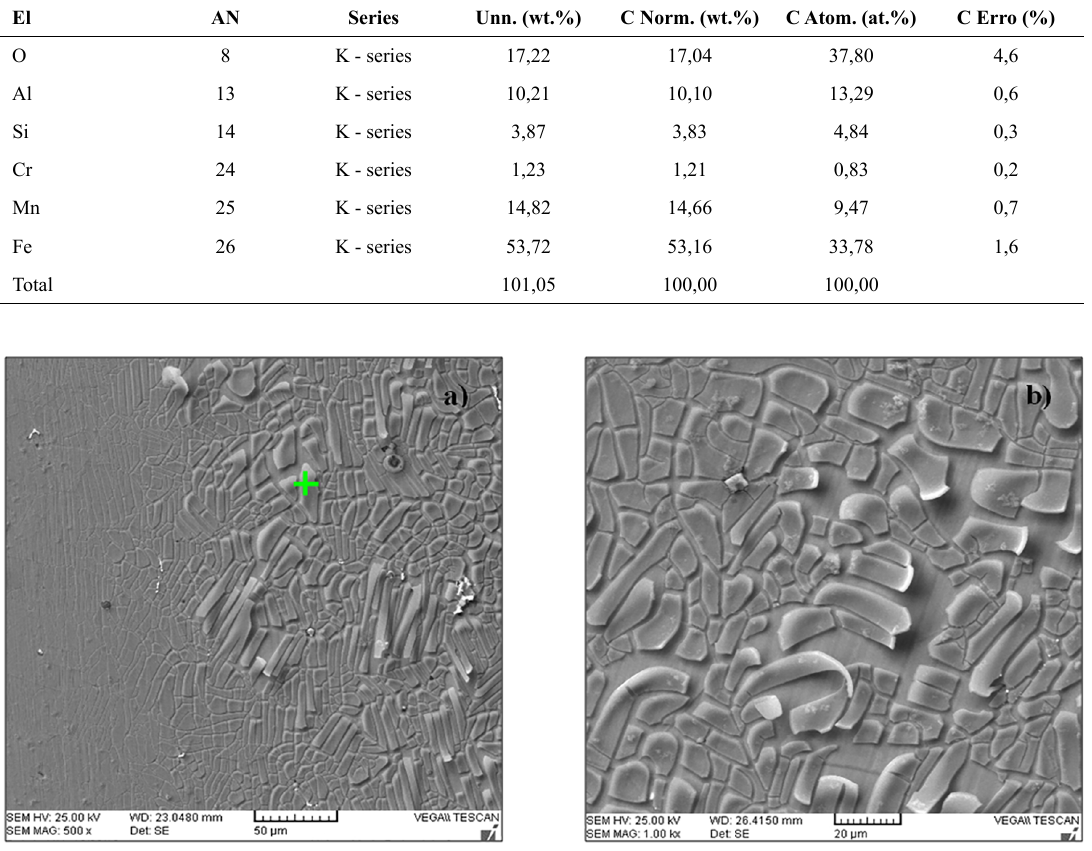
Table 2. Quantification of the elements in the corrosion products of the 20% manganese steel in solution 0.1M of NaCl made by EDS. Source: Acquisition Spectrum: